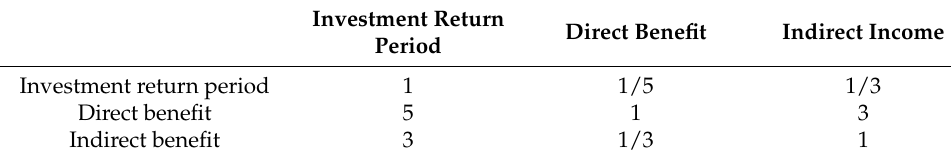
Table 7. Importance scale of the economic indicator.